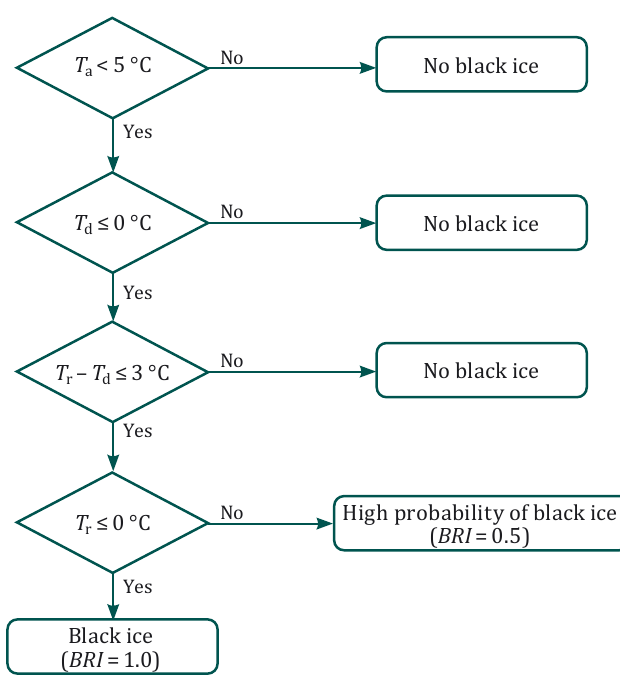
Figure 4. Black ice caused by freezing of wet road